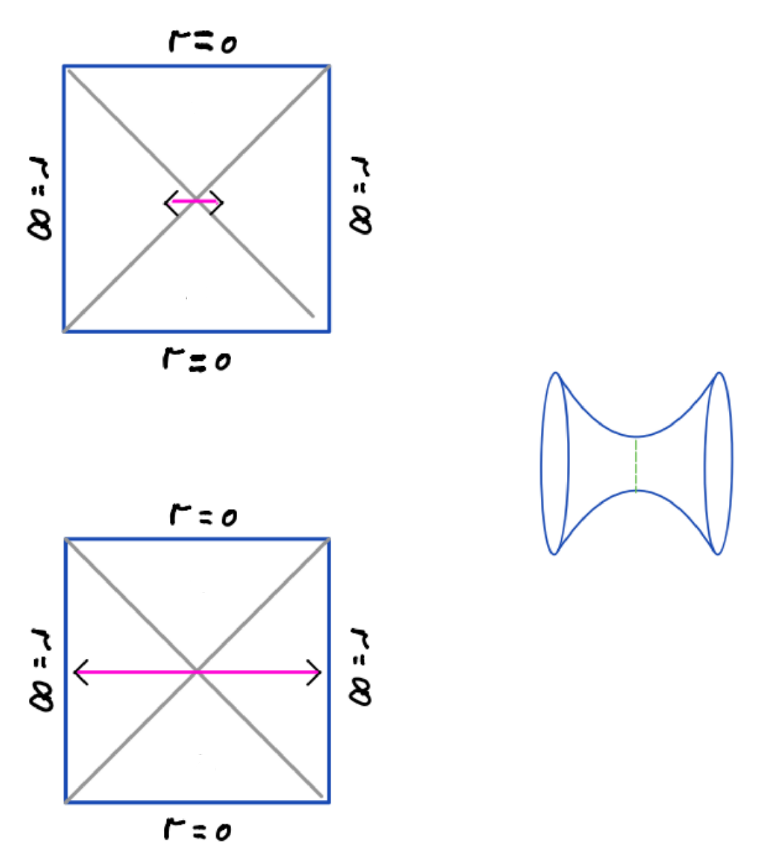
Figure 6. The AdS eternal black hole case: the upper panel introduces screens close to the horizon. According to the light-sheet entropy bound, the number of degrees of freedom on the screens is sufficient to represent the states of the black hole, but not sufficient to represent degrees of freedom in the space far from the horizons. In the lower panel, the screens are placed out near the AdS boundaries. In this case, the degrees of freedom on screens is sufficient to encode the entire